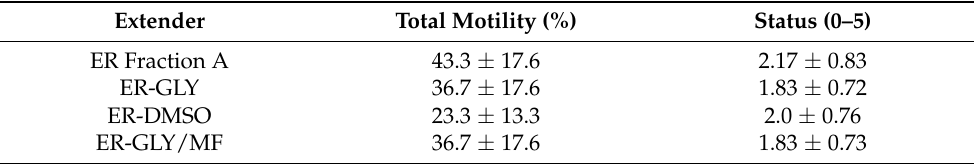
Table 2. Southern stingray ( Hypanus americanus ) (June n = 3) sperm motility parameters at 5 °C extend in various cryoprotecting agents ( x ± SEM).